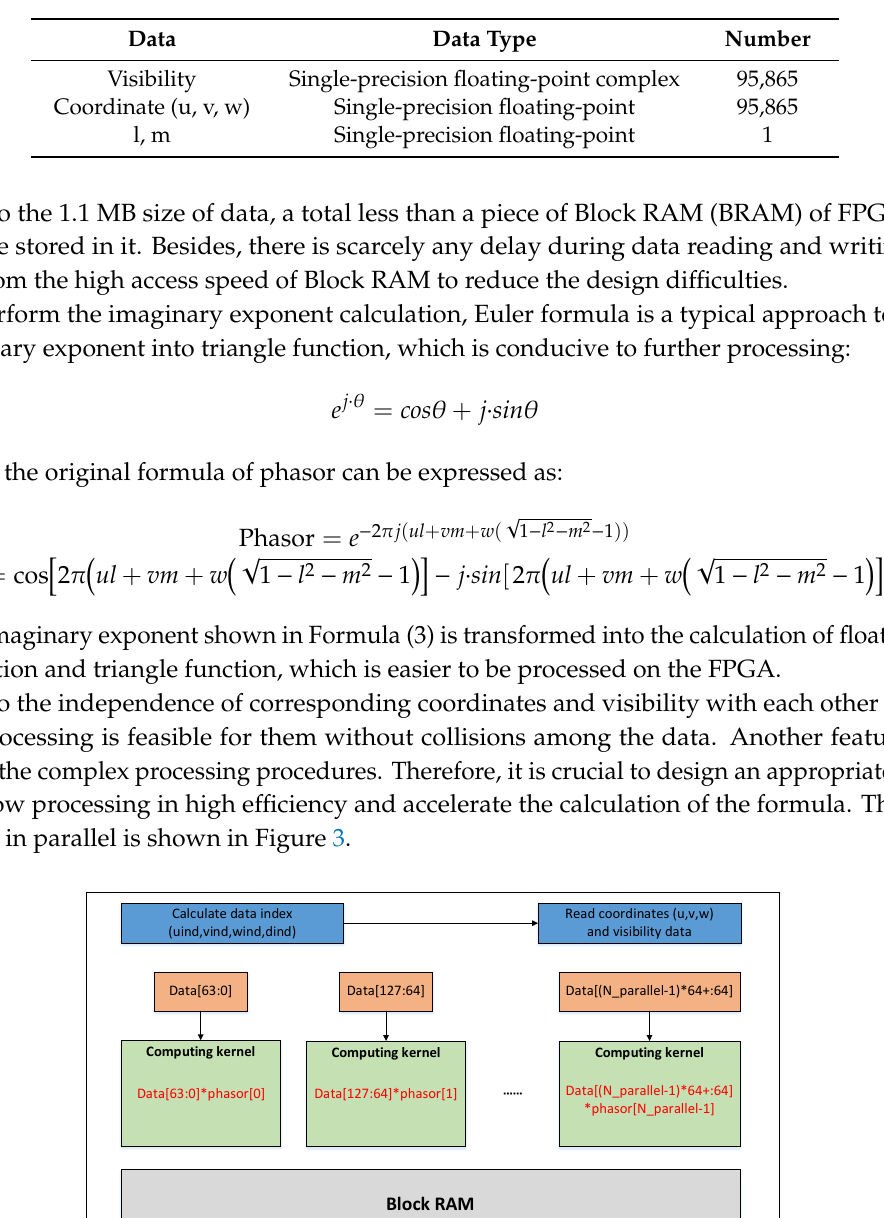
Table 2. Data magnitude in phase rotation acceleration system.